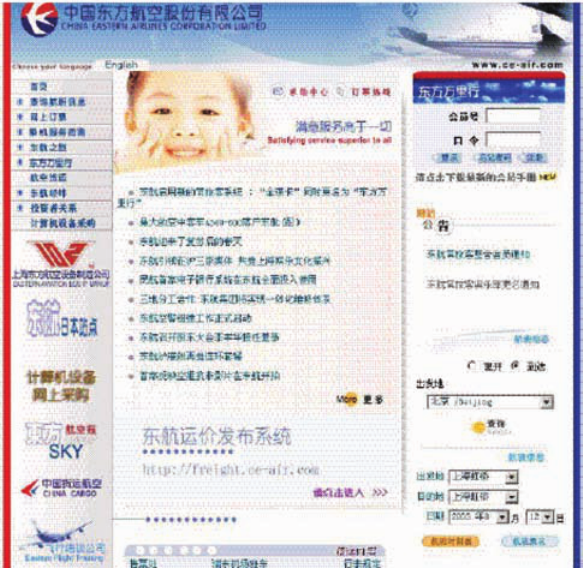
Fig 1. China Eastern targeting their domestic